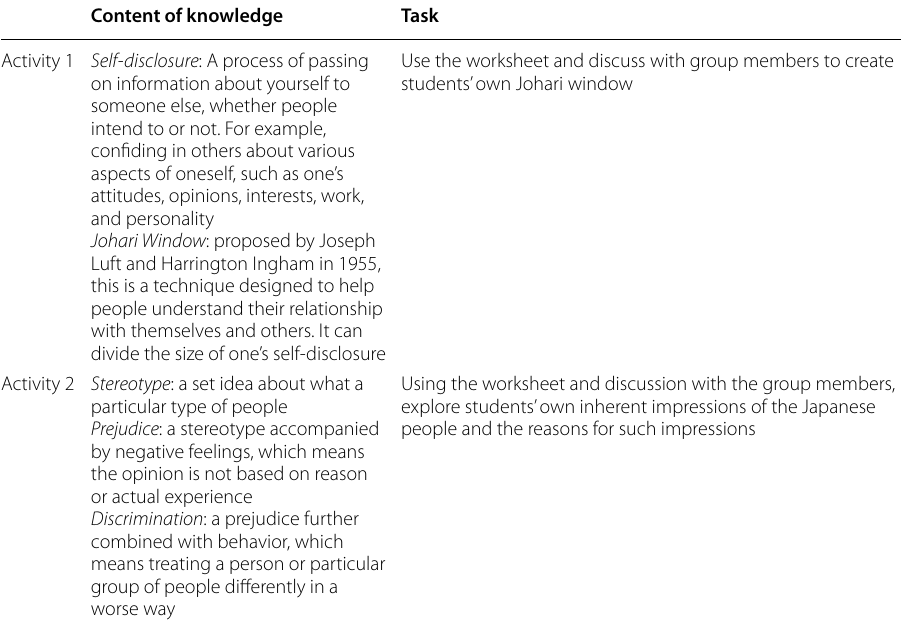
Table 2 Explanation of learning activities Content of knowledge